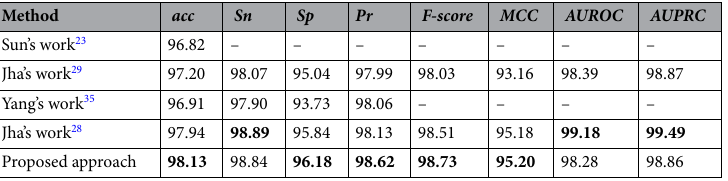
Table 9. Comparative analysis of the proposed approach with existing methods for human dataset. Best values are in bold.